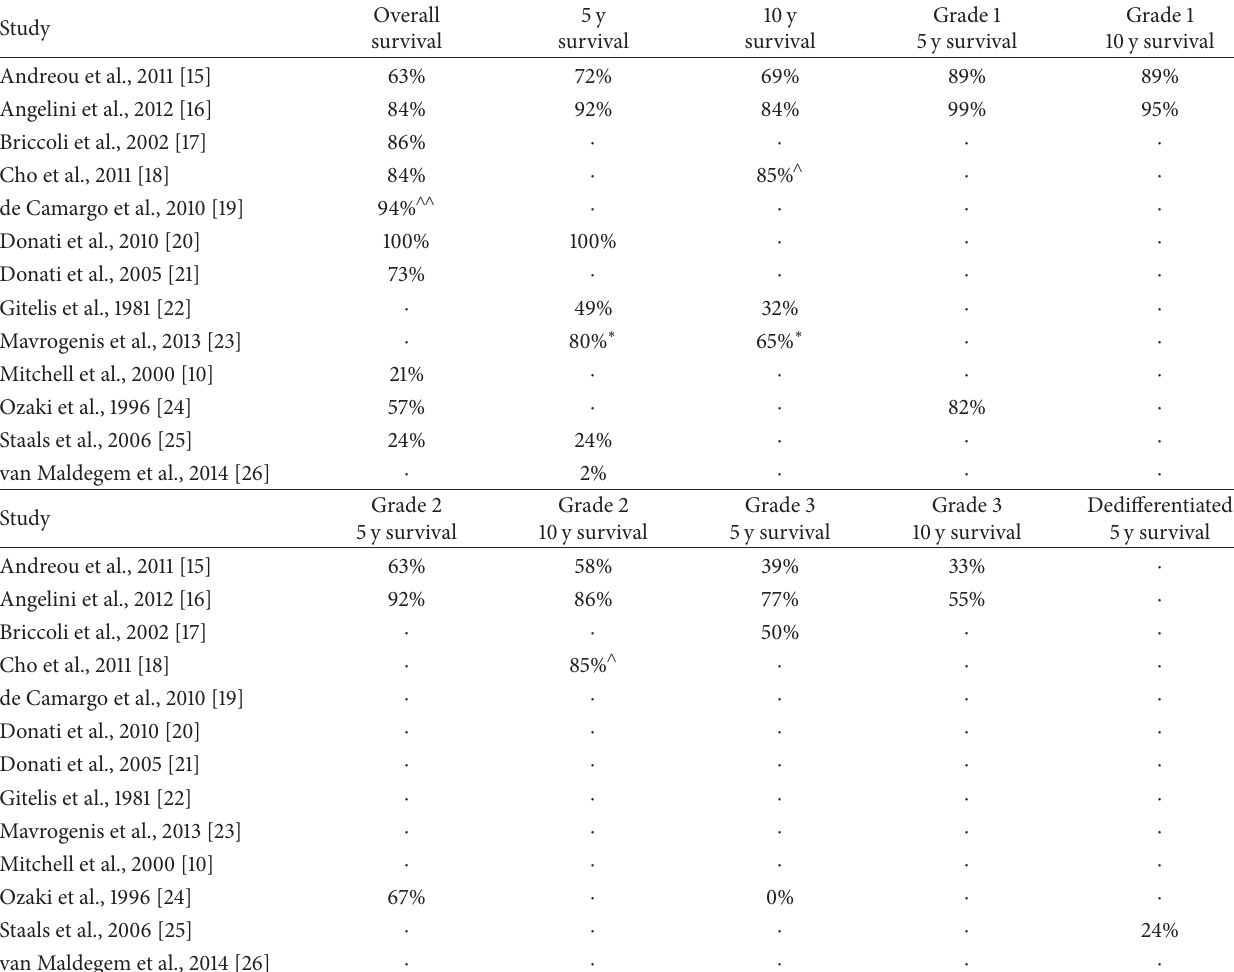
Table 3: Oncologic outcome, survival.